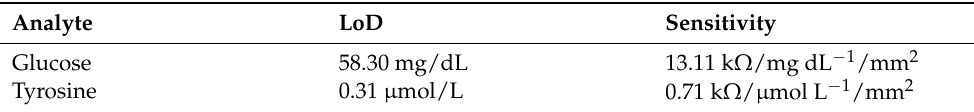
Table 1. Comparison of LoD and sensitivity towards glucose and tyrosine detection using benchtop EIS calibration.